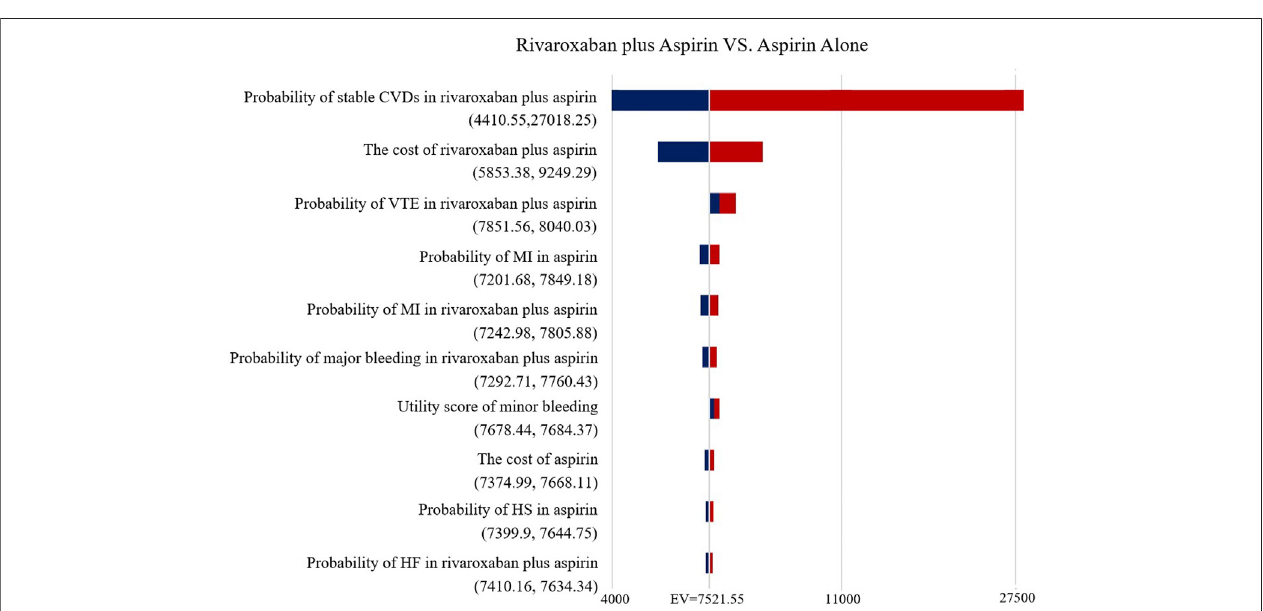
FIGURE 2 | Tornado diagram showing the deterministic sensitivity analysis of the Markov model simulation (Low-does rivaroxaban plus aspirin group vs. Aspirin alone group).